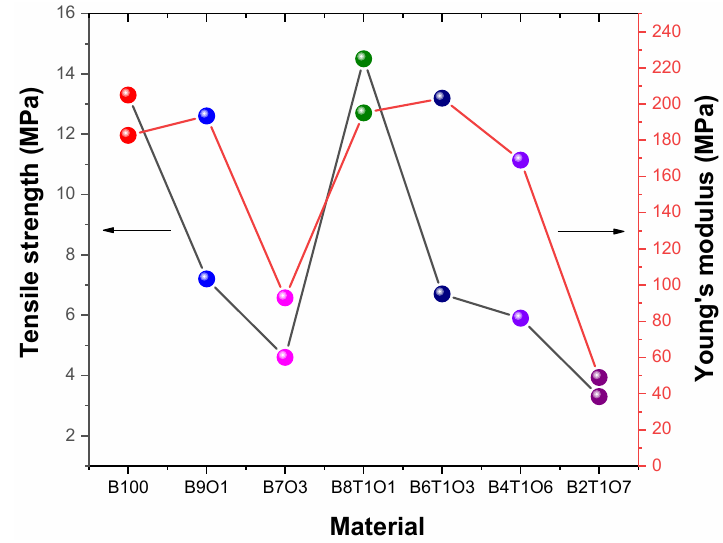
Figure 7. Tensile strength and Young’s modulus of the 3D-printed specimens.